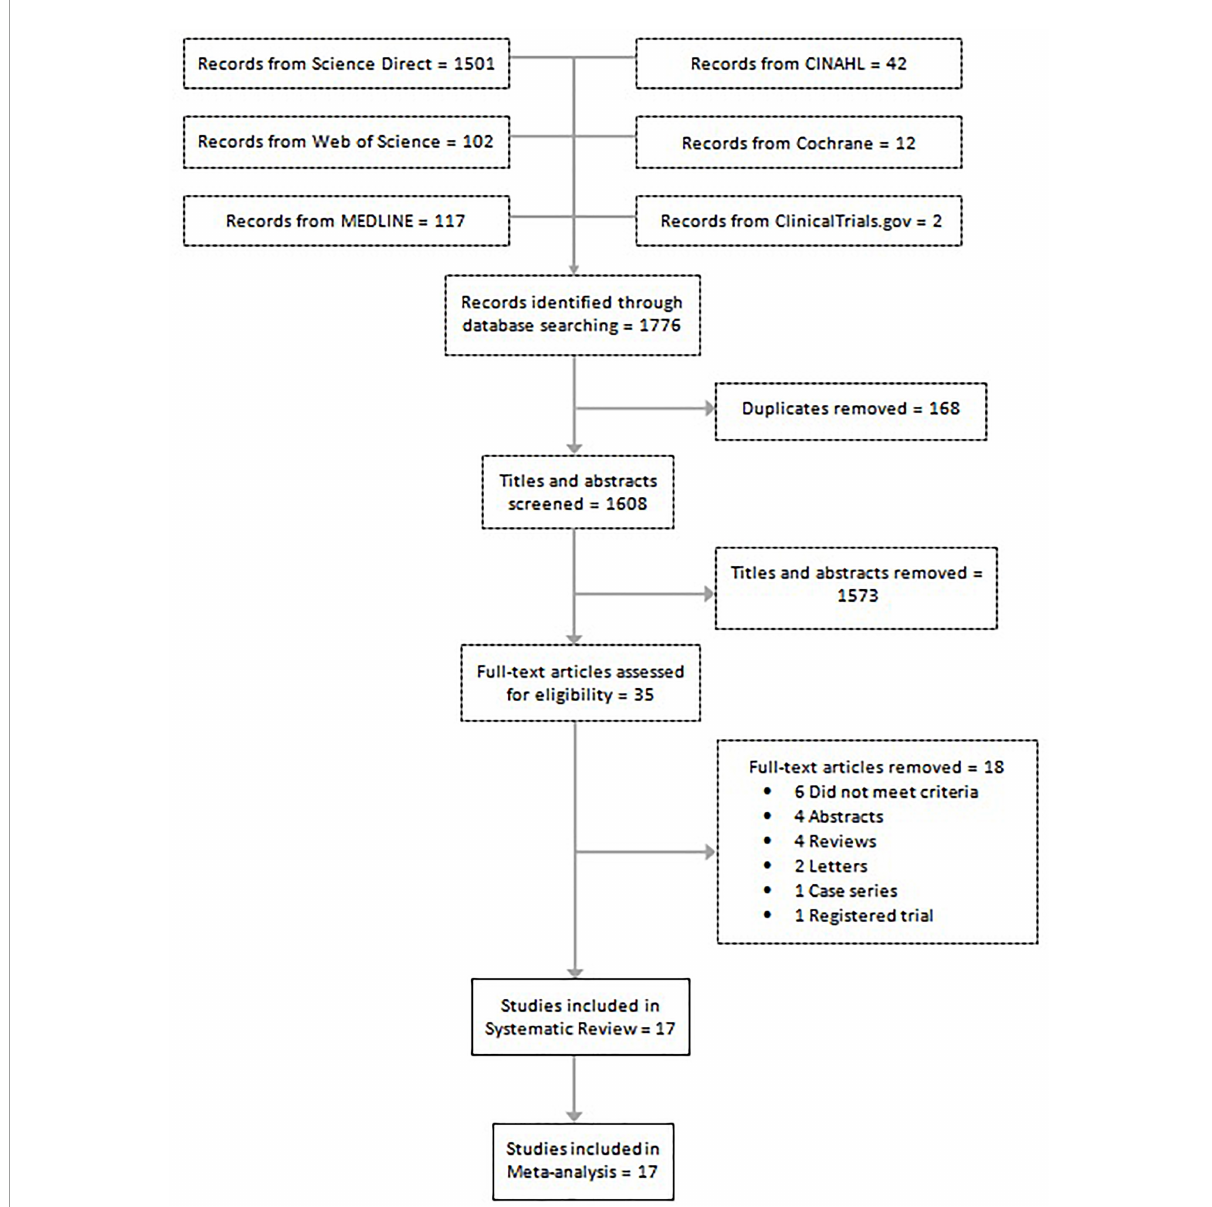
FIGURE1 Flow diagram shows the included studies for the systematic review and meta-analysis on endometriosis and irritable bowel